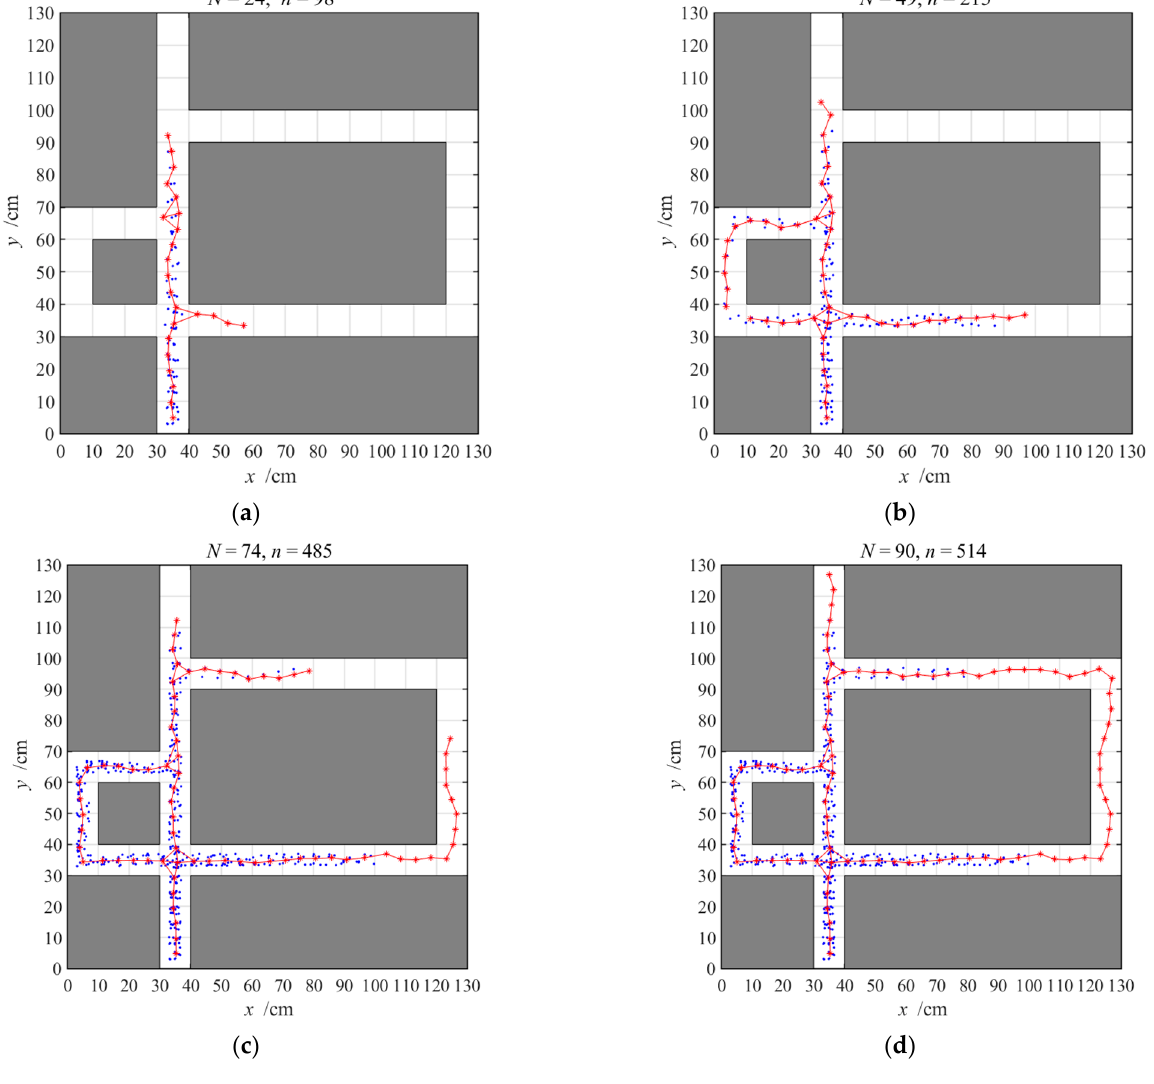
Figure 7. Navigation path with the hippocampal model alone. Red asterisks and the red lines linking them mark the generated cognitive map. Blue lines represent navigation path.